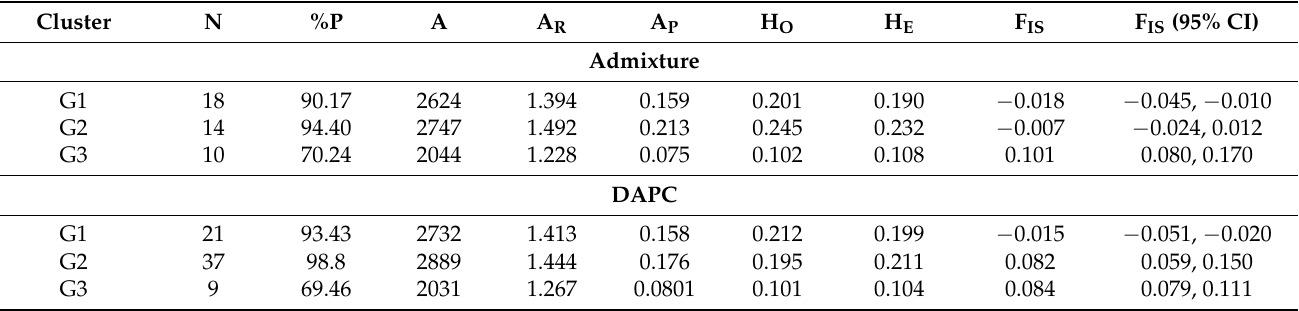
Table 1. Common measures of genetic diversity for 67 C. pubescens samples from the three inferred clusters ( K = 3) using 1462 unlinked biallelic SNPs.